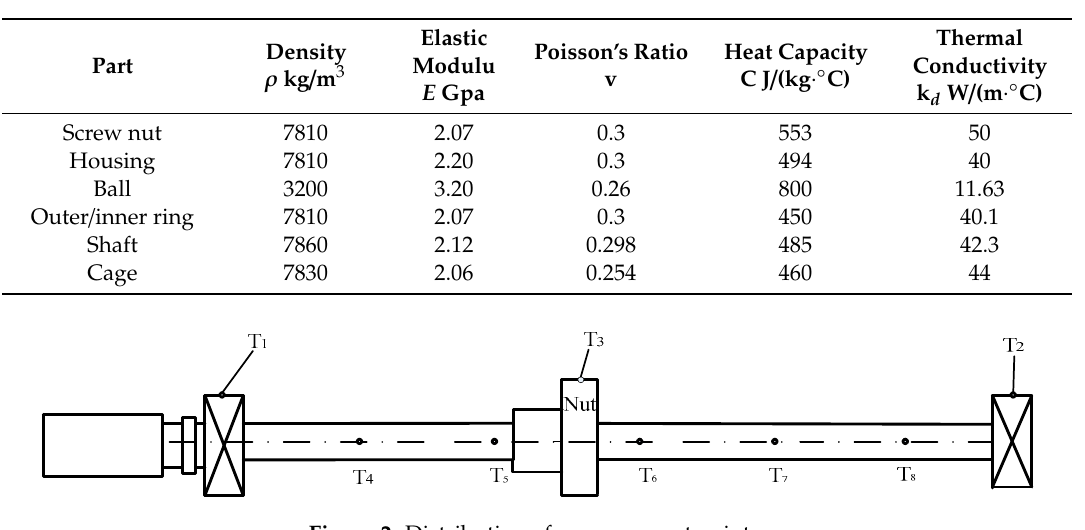
Table 1. Material properties on parts.